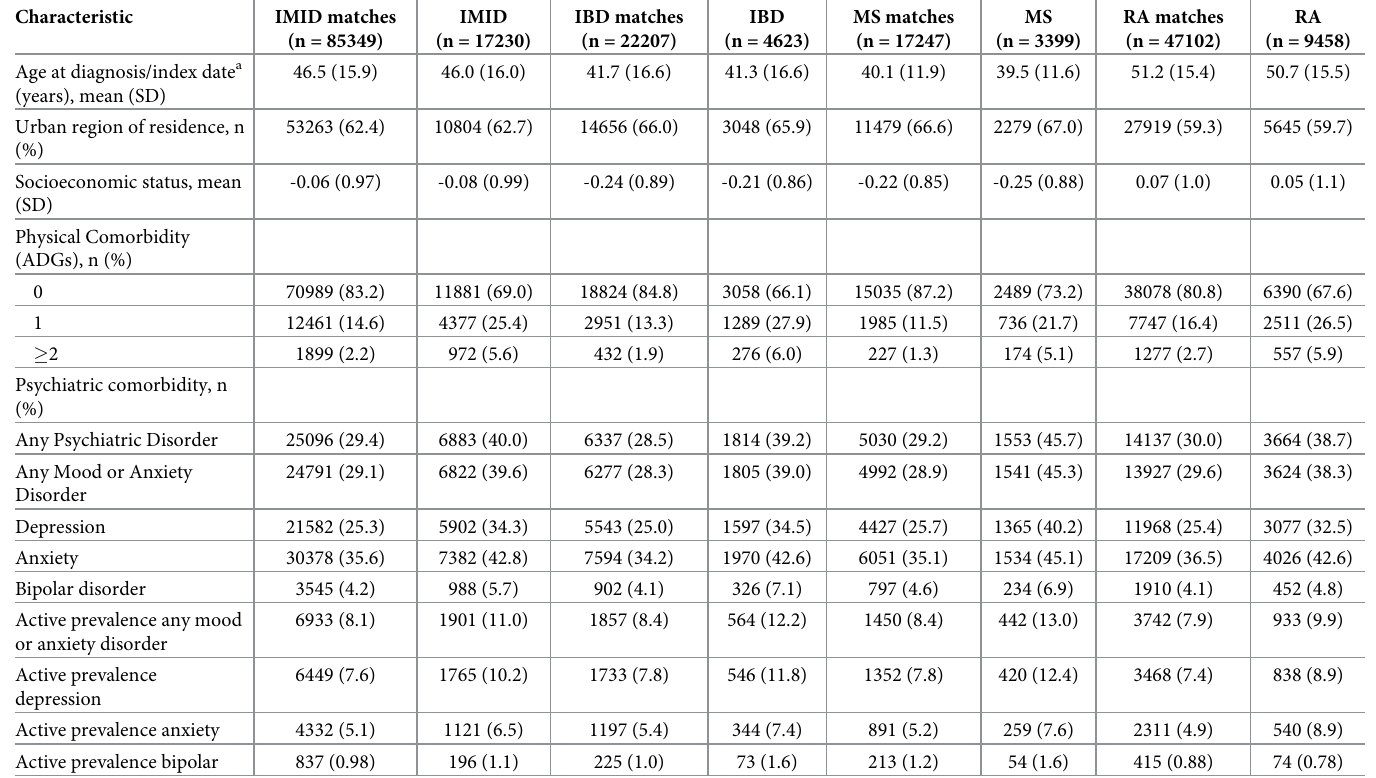
Table 1. Characteristics of prevalent disease cohorts and matched cohorts.